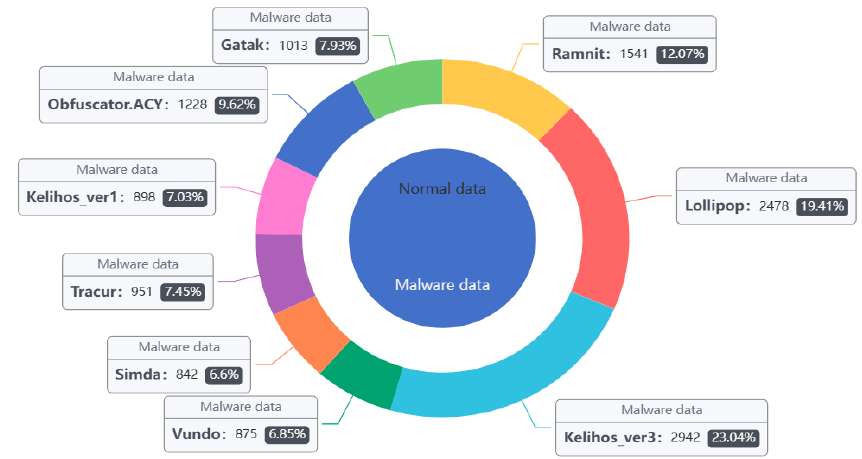
Figure 9. Sample distribution after Kaggle dataset expansion.